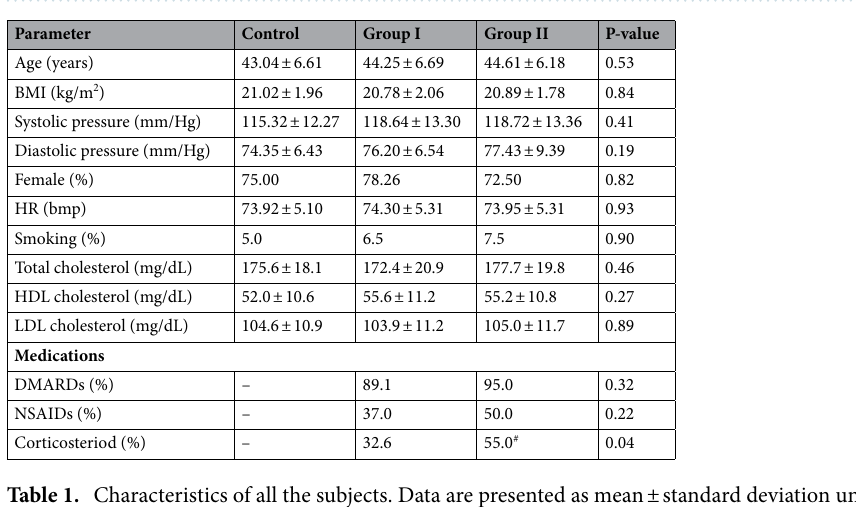
Figure 3. 2D-STI parameters of left atrium in Group II. 2D-STI parameters of left atrium obtained from apical four-chamber view in Group II ( A ). 2D-STI parameters of left atrium obtained from apical two-chamber view in Group II ( B ). LAGLS left atrial global longitudinal strain, LASr left atrial strain during reservoir phase, LAScd left atrial strain during conduit phase, LASct left atrial strain during contraction phase, LV left ventricle, LA left atrium, RV right ventricle, RA right atrium.